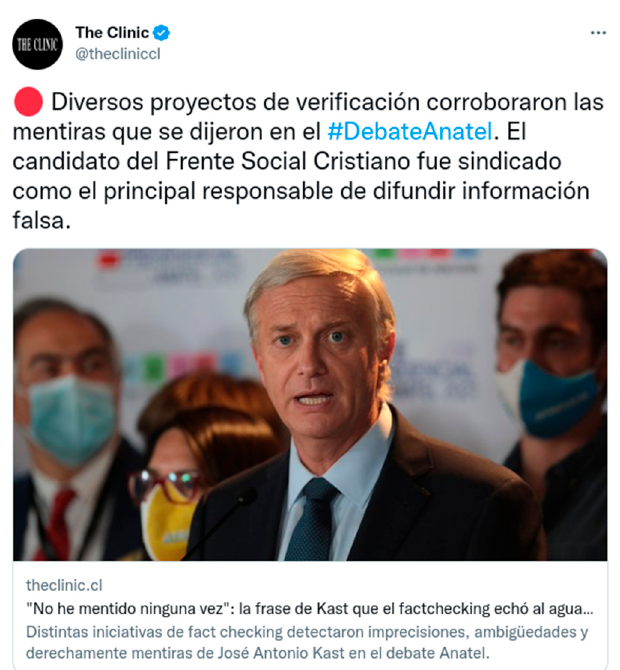
Figure 8. Exemplary case in